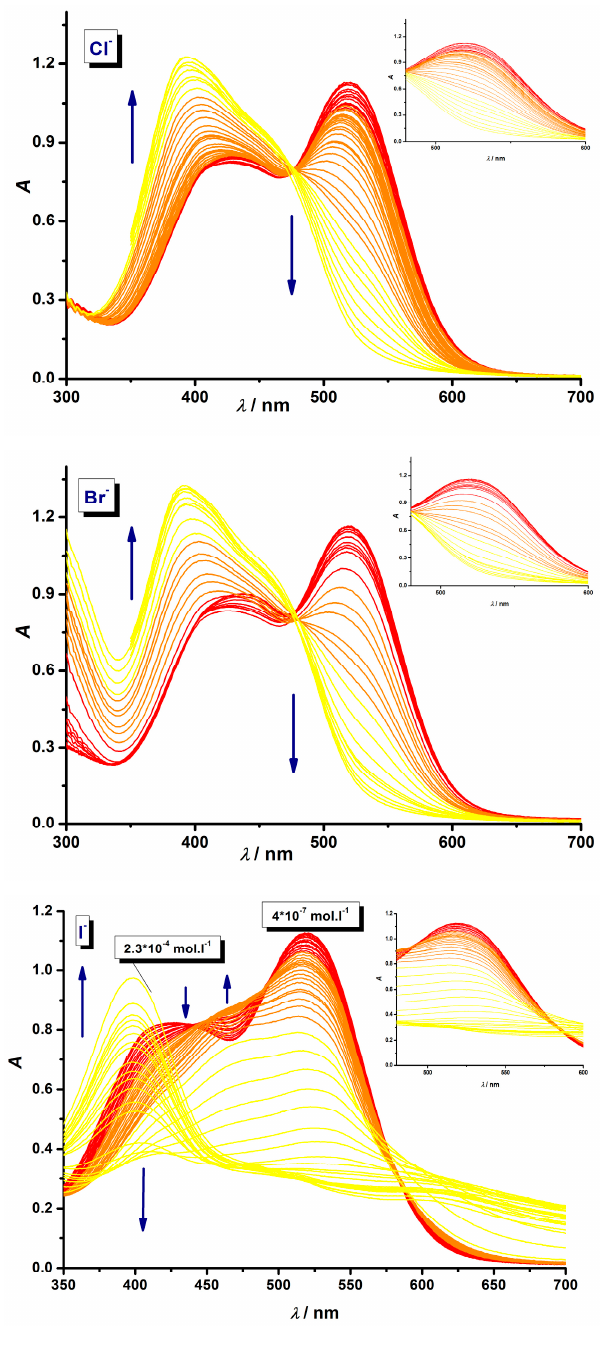
Figure 2. The examples of change in absorption spectra of Tl–PAR complex ( c Tl ~ 0.1 mM, ratio 1:1) after addition of halides in the concentration region of 10 − 5 –10 − 1 M (for more experimental details see Figure 3).